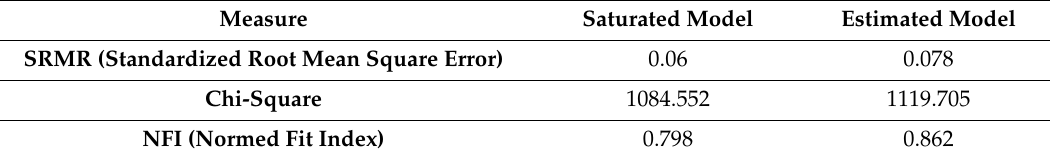
Table 6. Model Fit Indices.